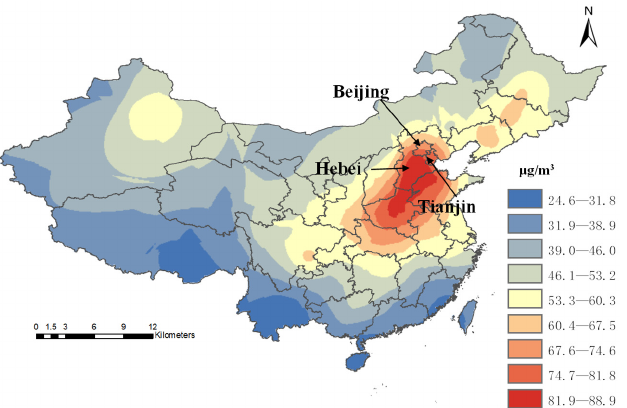
Figure 1. Spatial distribution of annual average concentration of PM 2.5 in China in 2015 and target study area (Beijing City, Tianjin City, and Hebei Province). The BTH region was designated as one of the key areas for air pollution prevention and control since the severe haze pollution occurred in early 2013 [13]. Diseases related to air pollution, including heart, cerebrovascular, and respiratory system diseases, were ranked second to fourth in death rate and composition from 10 major diseases in recent years [14].